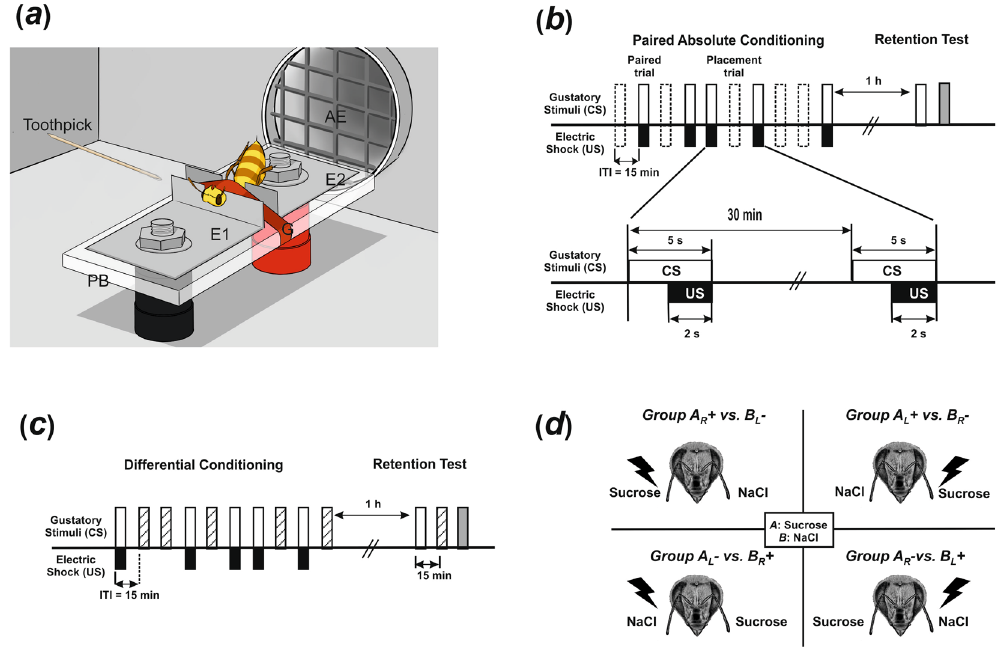
Figure 1. Associative gustatory conditioning of the sting extension reflex (SER) in honeybees. ( a ) View of a honeybee in the experimental set-up (drawing by Marie Guiraud). The bee is fixed between two brass plates (E1, E2) set on a Plexiglas basis (PB) by a girdle (G) that clamped the thorax to restrain mobility. EEG cream is smeared on the two notches to ensure good contact between the metal plates and the bee. The bee closes a circuit and receives a mild electric shock (7.5 V) which induces the sting extension reflex (SER). A tastant is delivered by a toothpick contacting the antennae. Pheromone contamination is avoided via an air extractor (AE) which is continuously on and placed behind the bee. ( b ) Experimental schedule for absolute gustatory conditioning of SER. Bees were trained with five paired presentations of a single tastant, sucrose (white bars), and electric shock (black bars). Five blank trials (dashed bas) were interspersed between conditioning trials to allow comparison with an unpaired group (not shown). The intertrial interval (ITI) was 15 min. One hour after the end of conditioning a retention test was performed in which the CS was delivered without shock (white bar). At the end of the test, the shock was delivered alone (grey bar) to check the integrity of SER. Each trial consisted of a gustatory stimulation (conditioned stimulus or CS) that lasted 5 s, followed by an electric shock (unconditioned stimulus or US) that started 3 s after tastant onset and lasted 2 s. ( c ) Experimental schedule for differential gustatory conditioning of SER. Bees were trained to discriminate two tastants (CS), one (white bars) paired 5 times with shock delivery (black bars, US) and the other presented 5 times without shock punishment (dashed bars). The intertrial interval (ITI) was 15 min. One hour after the end of conditioning a retention test was performed in which the two CSs were delivered without shock (white and dashed bars). At the end of the test, the shock was delivered alone (grey bar) to check the integrity of SER. Each punished trial was identical to those described in ( a ). Non-punished trials were similar except that no shock was delivered. ( d ) Experimental groups trained under the differential-conditioning regime to achieve balance between antennal sides and reinforcement contingencies of both tastants (bee head adapted from picture by Cyril Fresillon,